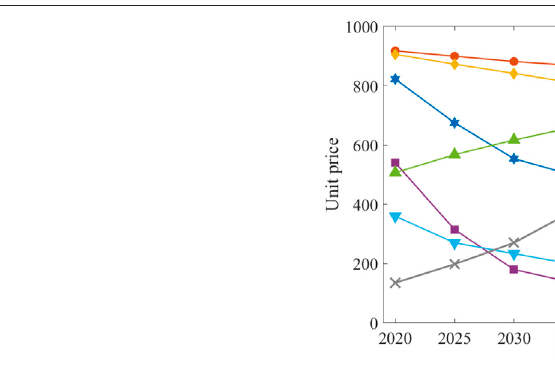
FIGURE 2 | Financial assumptions for components of future